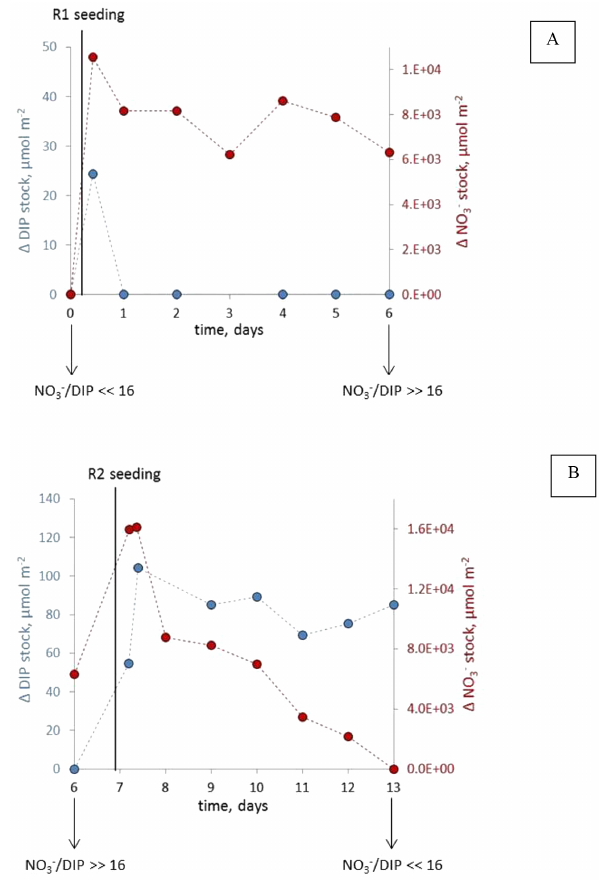
Figure 7. Averaged temporal changes in the variation (Dust- Control) in NO − (red dots) and DIP stocks (blue dots) (A) after 3 the DUNE-2 R1 seeding and (B) after the DUNE-2 R2 seeding.